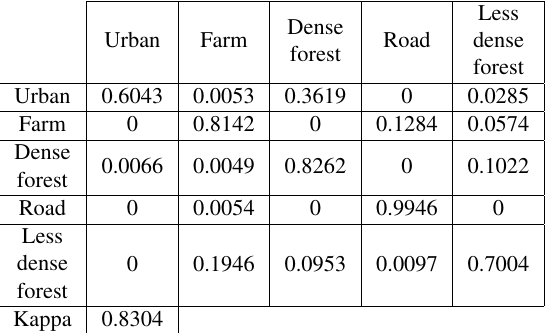
Table 1. Standard GMM confusion matrix